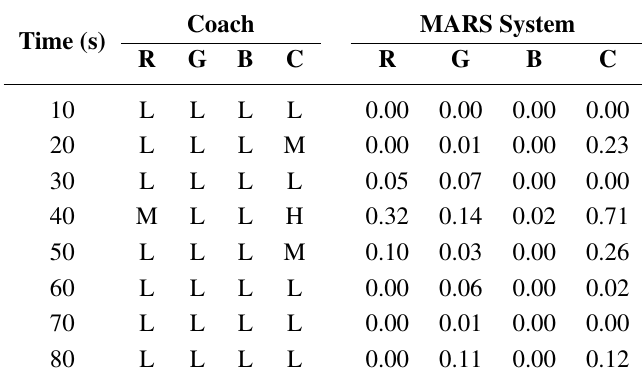
Table 7. Session E , coach and system